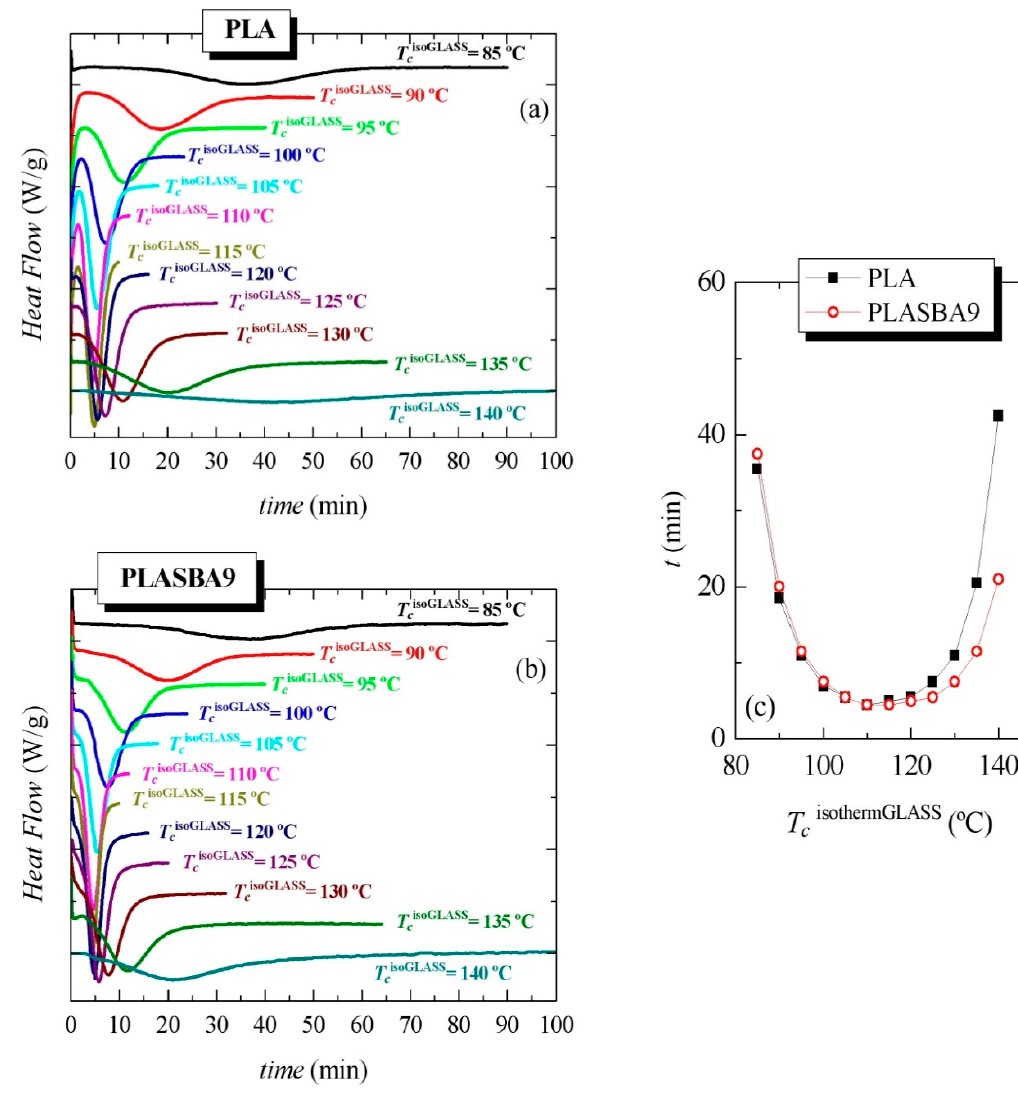
Figure 8. Dependence of heat flow on time for isothermal crystallization from the glass, T c isothermGLASS , at the indicated temperatures for ( a ) PLA and ( b ) PLA-SBA9. ( c ) Comparison of the peak crystallization times as a function of T c isothermGLASS in PLA and PLA-SBA9.